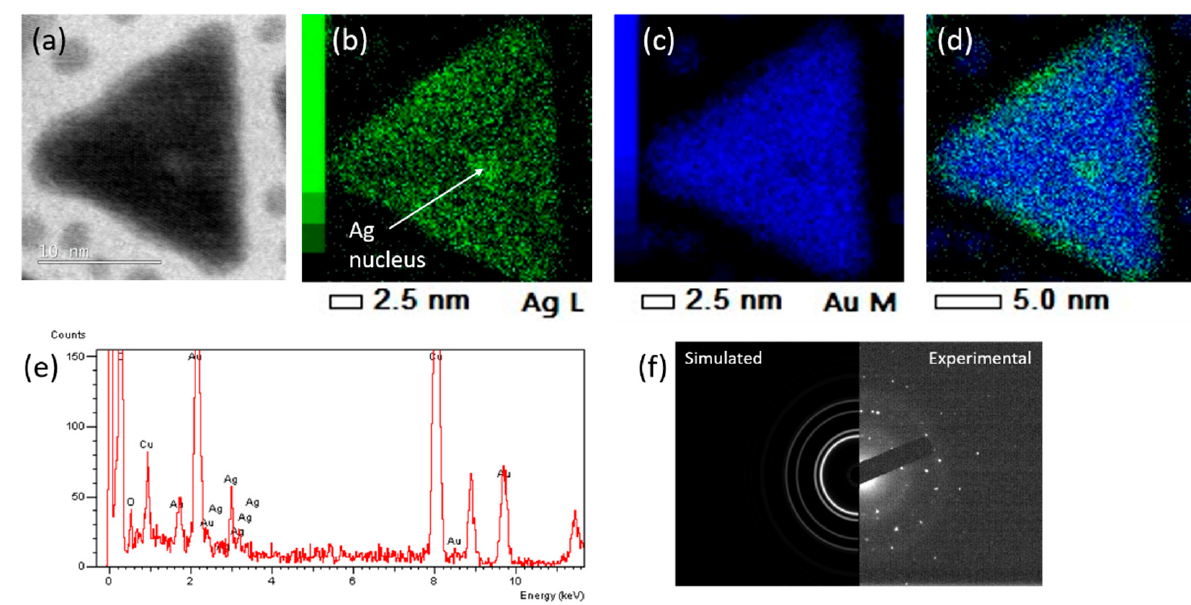
Figure 2. ( a ) TEM image of AuAgNTrs@PEG. Energy dispersive X-ray spectrum (EDXS) mapping of ( b ) Ag and ( c ) Au signal. ( d ) Overlap image composed of the Ag and Au EDXS signal. ( e ) Representative EDXS spectrum (Cu peaks belong to TEM grid) and ( f ) selected-area electron-diffraction (SAED) pattern analysis for observed nanotriangles compared to the simulated reflections for the Au face-centered cubic (FCC) crystal structures.